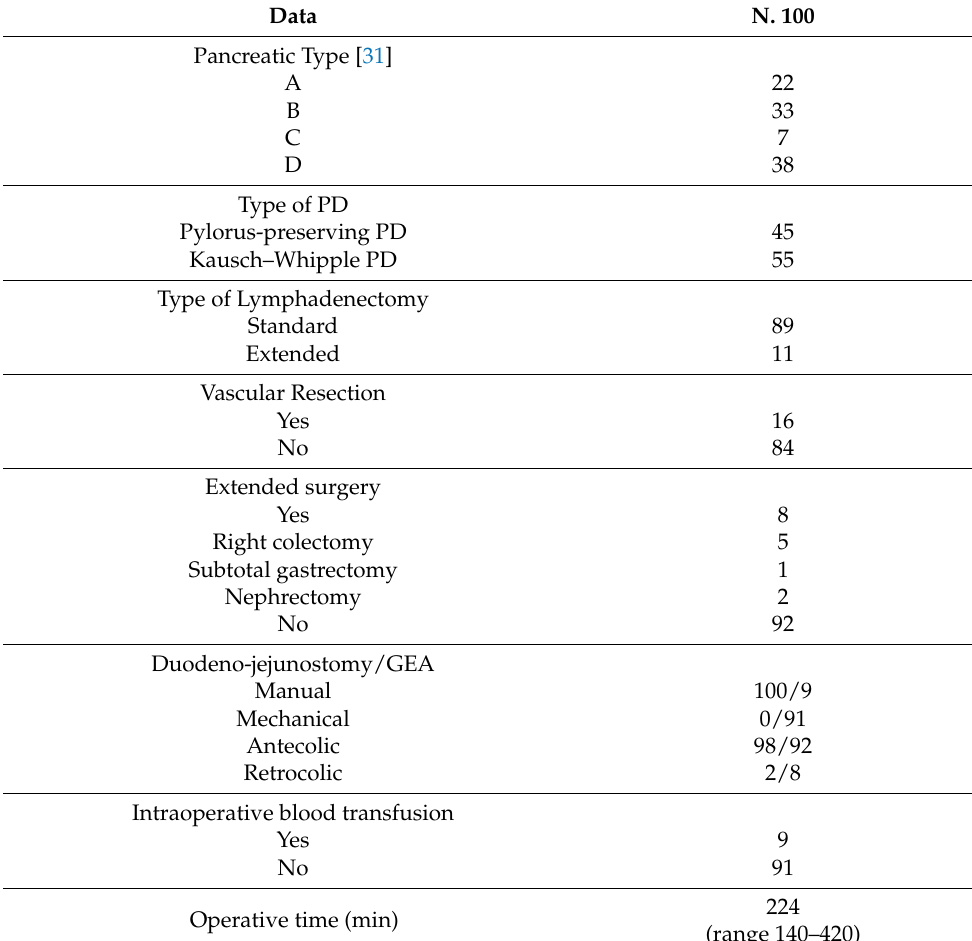
Table 2. Intraoperative Data .